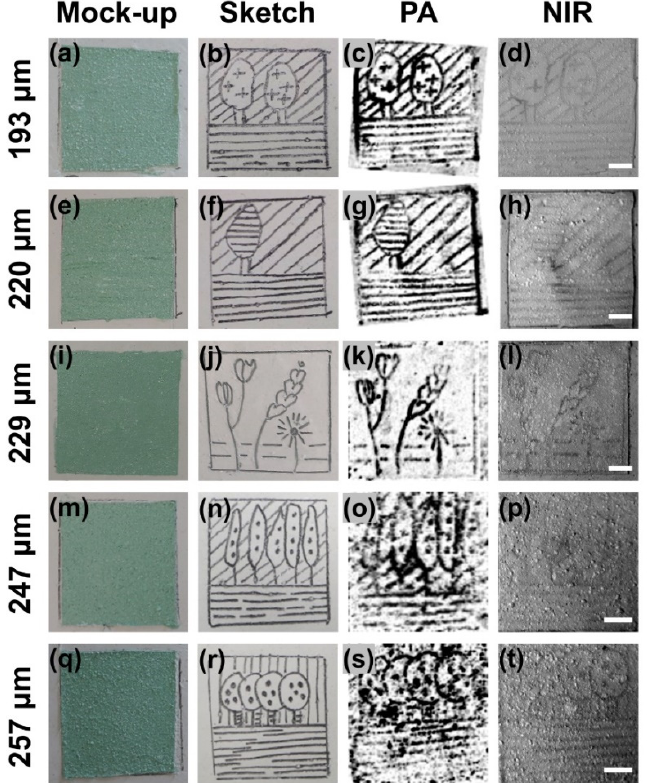
Figure 4. Images ( a ) of a mock-up covered by a mixture of chromium green and titanium white paint layer, ( b ) of the underlying pencil sketch prior to overpainting; ( c ) MAP PA reconstruction of the hidden sketch; ( d ) respective NIR image recorded at 1100 nm. Similar results are presented for mock-ups covered by paint layers of identical composition but with a gradually increasing average thickness, as presented on the left side of the panel ( e – t ). All scale bars are equal to 5 mm.